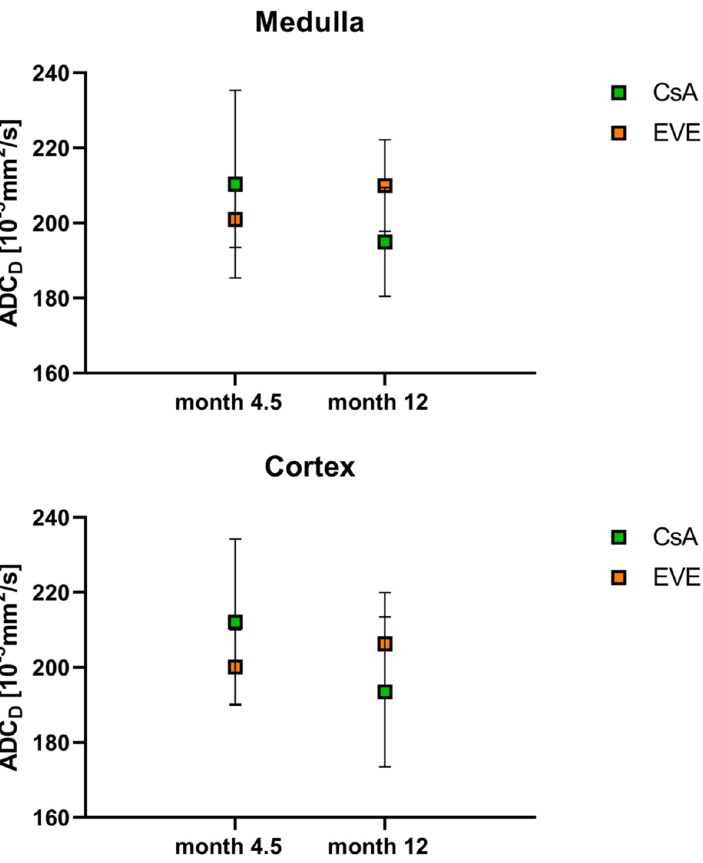
Figure 3. DWI-derived diffusion coefficient. Diffusion coefficient ADC D according to medication group and time-point in medulla and cortex.